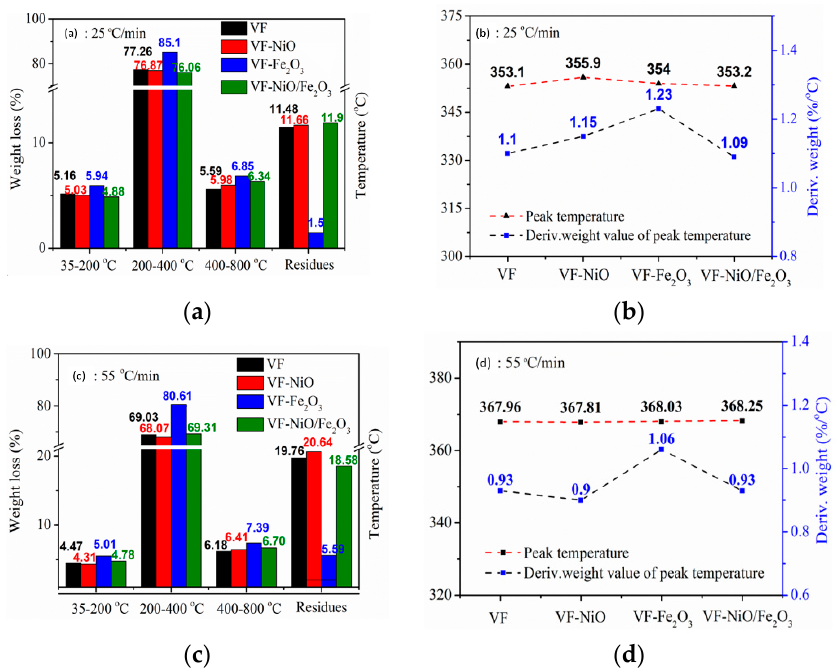
Figure 3. Thermal properties of Vernicia fordii wood : ( a ) the weight loss of different decomposition stages at the heating rate of 25 °C/min; ( b ) the peak temperature of DTG curves and the decomposition rate (25 °C/min); ( c ) the weight loss of different decomposition stages at the heating rate of 55 °C/min; ( d ) the peak temperature of DTG curves and the decomposition rate (25 °C/min).